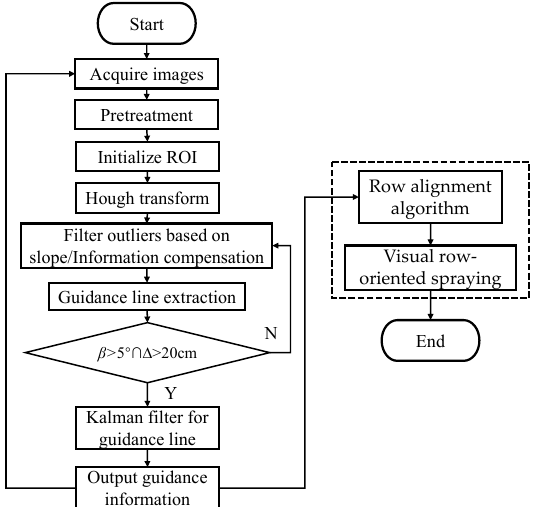
Figure 3. Guidance line extraction procedure for row-oriented spraying.